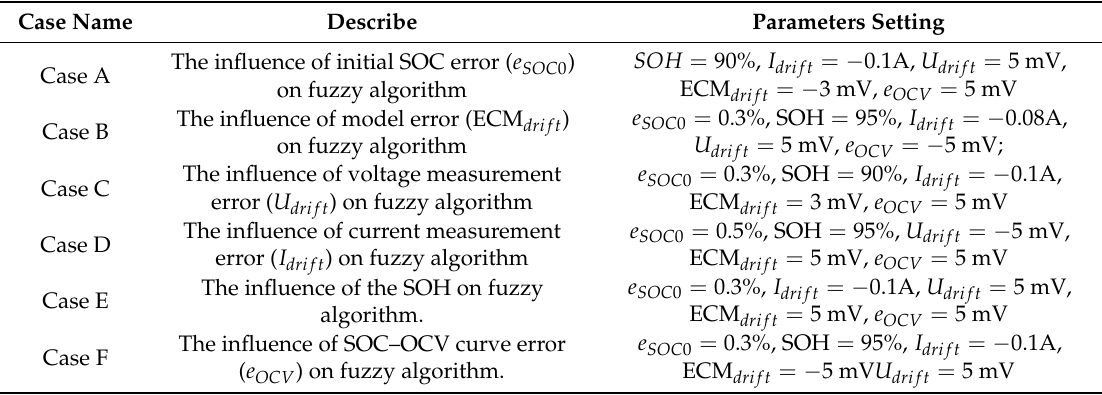
Table 5. Case and parameter